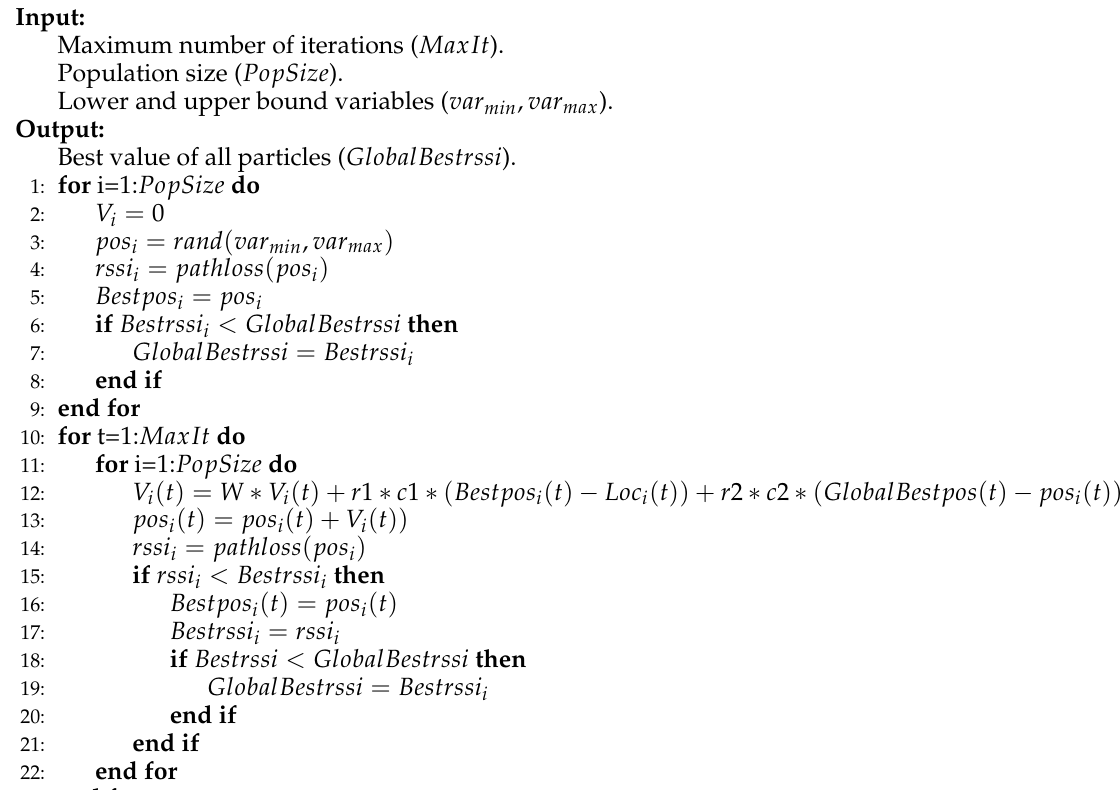
Algorithm 1 Particle Swarm Optimization (PSO)